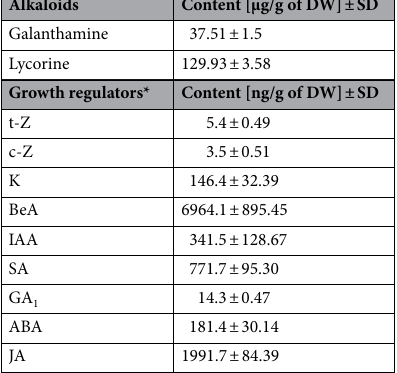
Table 1. Amaryllidaceae alkaloids and growth regulators content in Paenibacillus lautus strain PLV. The results are means of three replicates (n = 3) ± SD. Different letters indicate a significance difference at P < 0.05 according to ANOVA and Duncan’s test. DW, dry weight. *Z, zeatin; K, kinetin; BeA, benzoic acid; IAA, indoleacetic acid; SA, salicylic acid; GA 1 , gibberellin A 1 ; ABA, abscisic acid; JA, jasmonic acid.